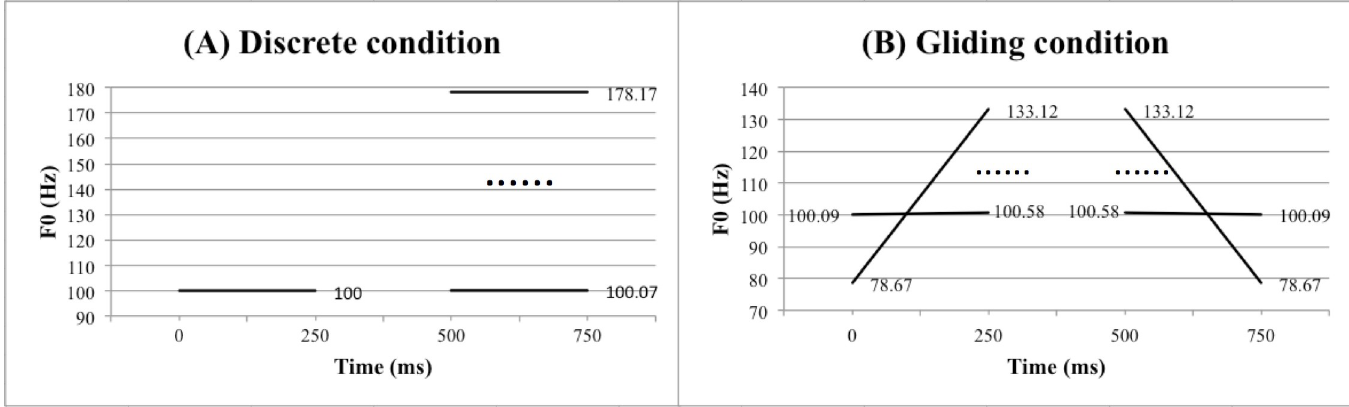
Fig 1. An illustration of the F0 manipulations in the discrete (A) and gliding (B) condition in the pitch threshold task. See text for a detailed description of this task.